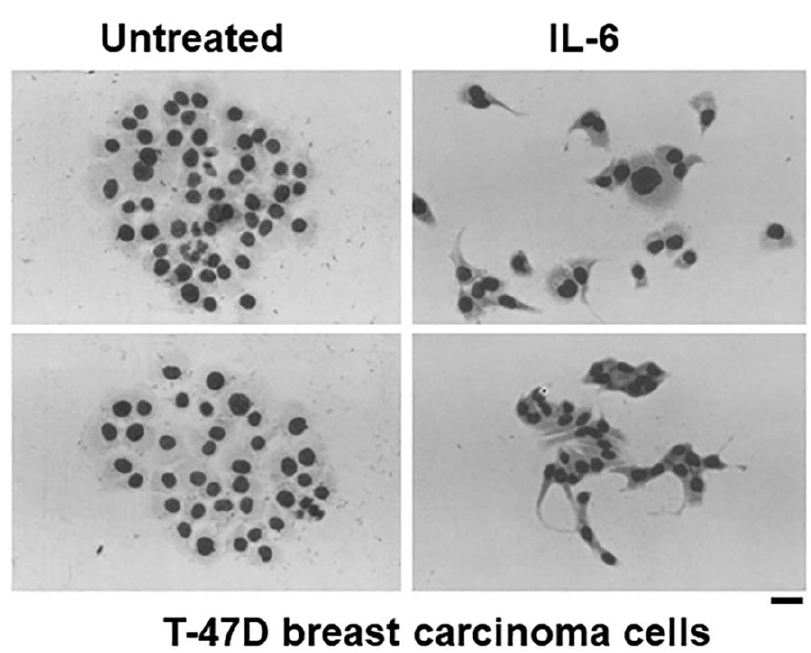
Figure 1. IL-6 increases motility of T-47D ductal breast carcinoma cells. T-47D cells plated at a low density (42 cells/cm 2 in T-25 flasks) were either left untreated or exposed to rIL-6 (150 ng/mL) for 11 days as indicated. Two representative colonies (Giemsa-stained) under each experimental condition are illustrated. Scale bar = 20 µm. Adapted from Tamm et al., 1989 [3].